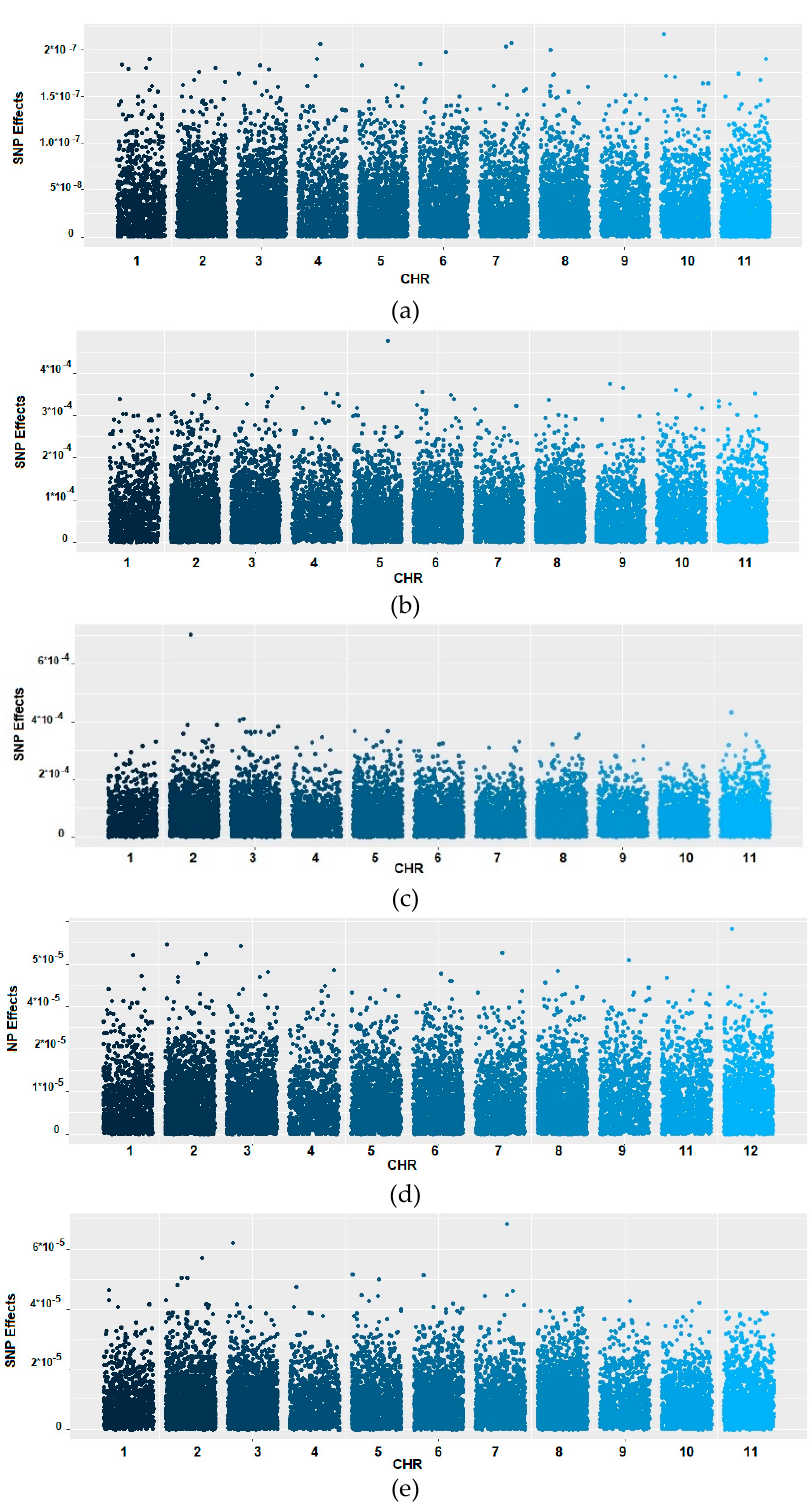
Figure 5. Absolute values of the SNP effects ( n = 14,442) estimated by RRBLUP (without cross-validation) for ( a ) wood volume, ( b ) stem straightness, ( c ) branching quality, ( d ) diameter at breast height, and ( e ) tree height.